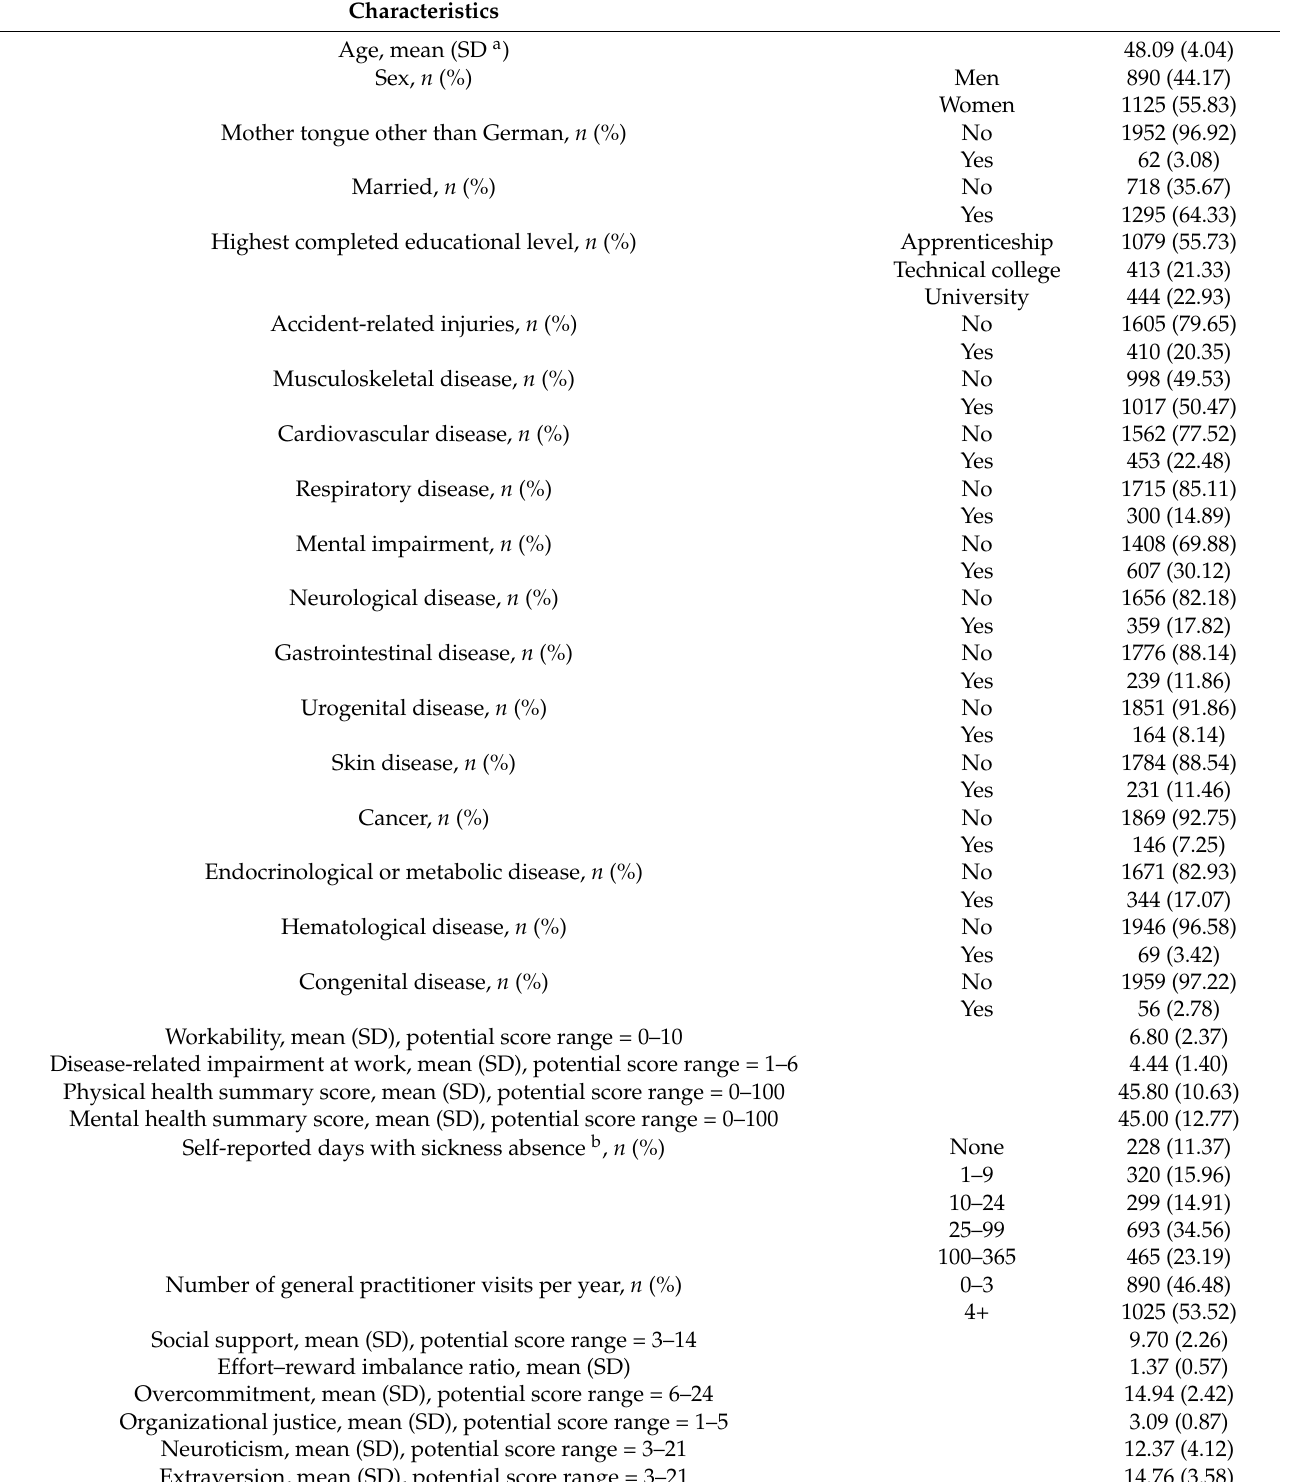
Table 1. Baseline characteristics of the study population.